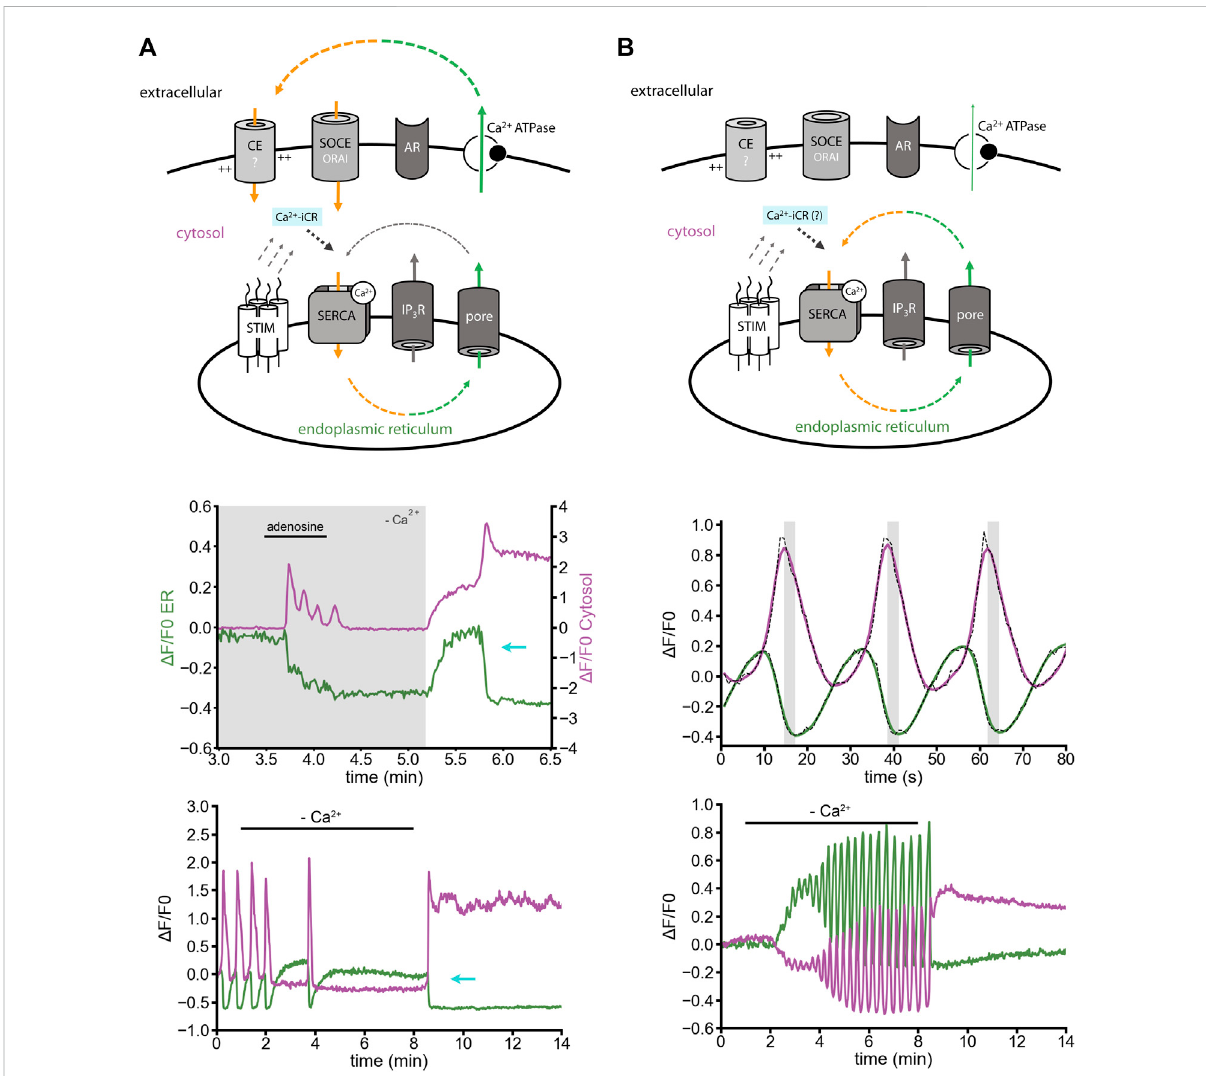
FIGURE 2 Induced ER Ca 2+ release versus ER Ca 2+ oscillation in cultured astrocytes. Simultaneous imaging of ER and cytosolic Ca 2+ with the indicators: ER-GCaMP6-150 (green) and Cal-590-AM (magenta) in non-disrupted cells. (A) Minimal model: Ca 2+ -induced Ca 2+ release (Ca 2+ -iCR, cyan) is induced by SOCE-like Ca 2+ entry after ER replenishment. Middle panel: In Ca 2+ -free solution, adenosine-induced Ca 2+ oscillations persist for about half a minute. Delayed Ca 2+ replenishment induces a Ca 2+ -iCR phenomenon, in absence of ryanodine receptors (cyan arrow). Lower panel: Removal of extracellular Ca 2+ and subsequent re-adding of extracellular Ca 2+ can be suf fi cient to stimulate Ca 2+ -iCR. (B) (Minimal model) Spontaneous Ca 2+ oscillation in Ca 2+ -free solution. (Middle panel) Spontaneous Ca 2+ oscillations are shaped by a circular relationship between ER and cytosolic signals. Simultaneous imaging revealed a time lag of some seconds between peak signals in the cytosol and the ER Ca 2+ release signal (grey). Raw traces (black dashed line) and the low-pass fi ltered traces (in color) are plotted. Lower panel: Spontaneous Ca 2+ oscillation in Ca 2+ -free solution. The sarco-/endoplasmic reticulum Ca 2+ ATPase (SERCA) recycles intracellular Ca 2+ . Candidates for ER Ca 2+ leak are IP 3 receptors and ER Ca 2+ leakchannels.Ca 2+ releasedfromtheERstaysinthecell,isnotexportedtoextracellularsides(comparewithFigure3),andtheSERCAadaptsits activity to the cytosolic Ca 2+ concentration. [Modi fi ed according to (Schulte et al.,